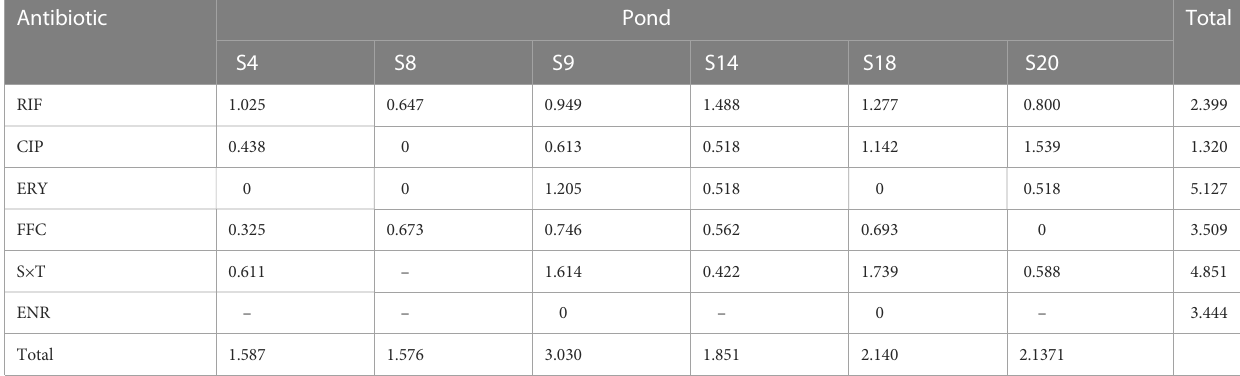
TABLE 1 Shannon – Weiner Index of ARB to different antibiotics in sea bass culture ponds.